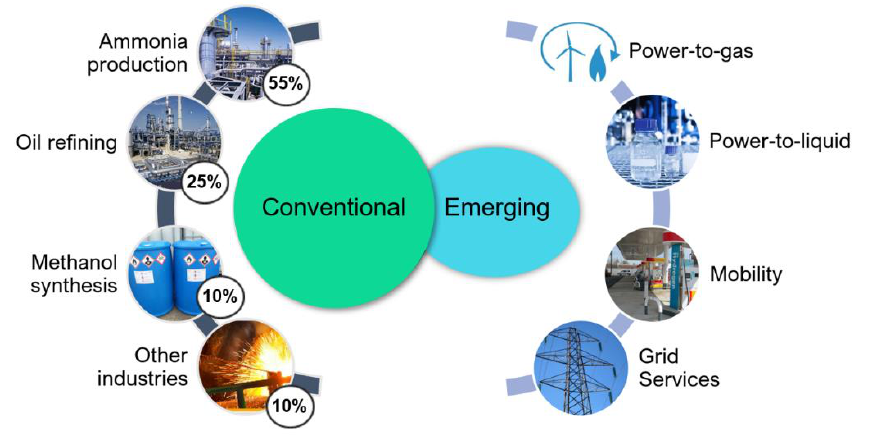
Figure 4. Overview of conventional and emerging hydrogen market segments, including the market share (adapted from [27,29] with permission by John Wiley and Sons).